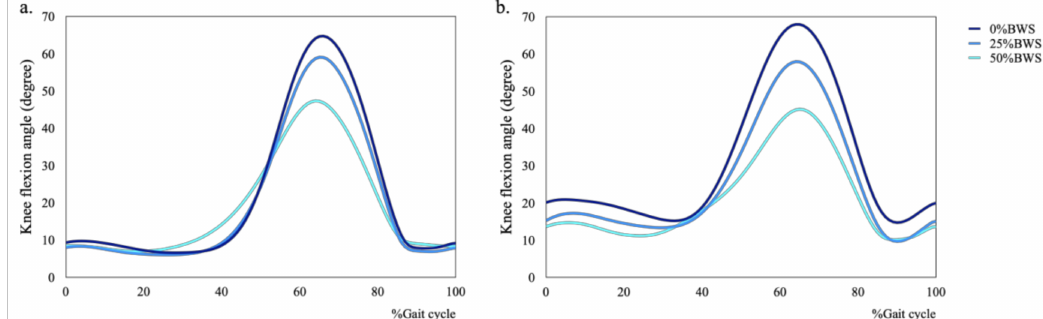
Figure 5. Mean plots of knee flexion during walking under 0%, 25% and 50%BWS conditions (( a ) male, ( b )